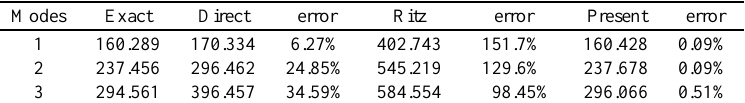
Fig. 2. Initial design of truss structure. Table 2 The frequencies of modified structure